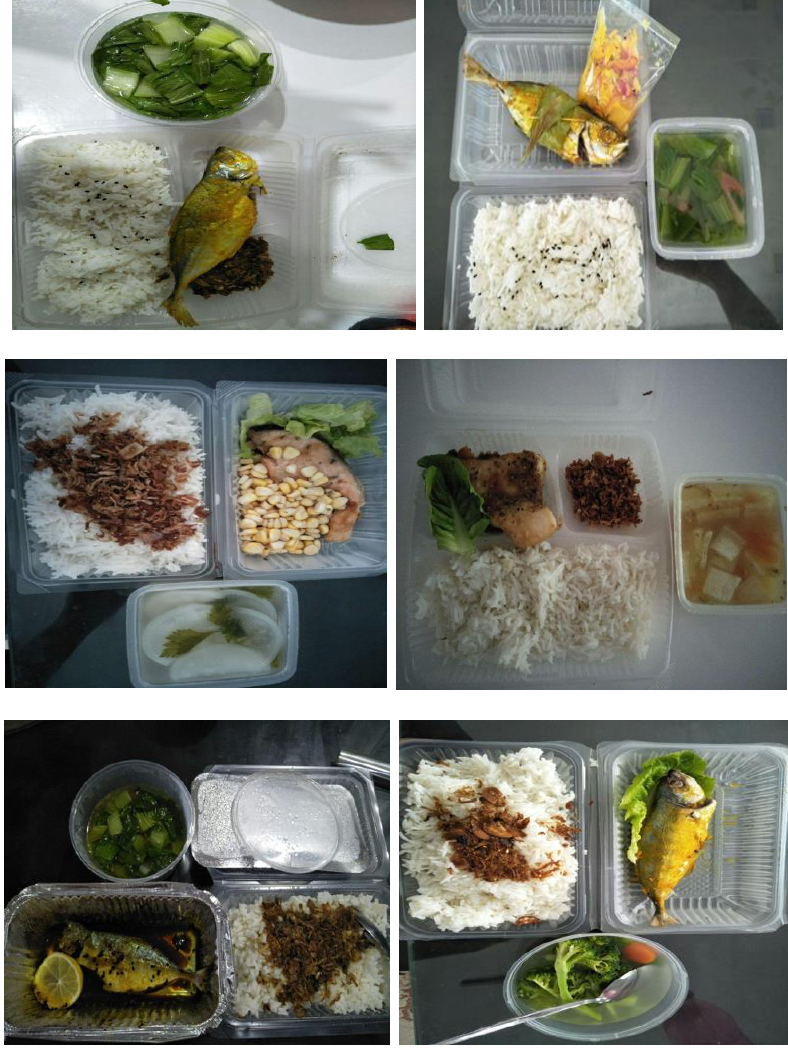
Figure 1: Some of the confinement